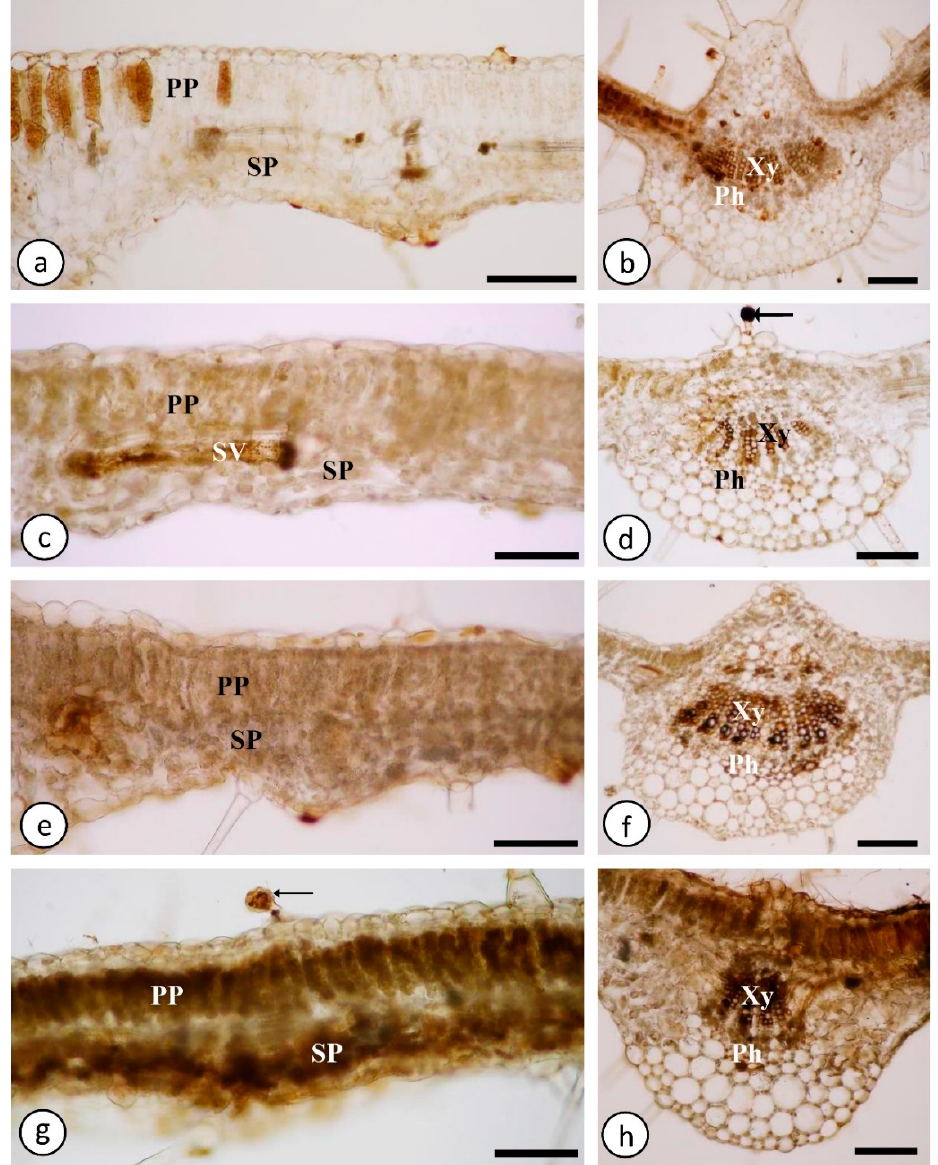
Figure 4. Photomicrographs of the median cross sections of the leaf blade of Solanum lycopersicum “cv Micro-Tom” stained with 3,3 ′ -diaminobenzidine (DAB) at 21 days after mechanical damage. ( a , b ). absence of Ca 2+ and without mechanical damage. ( c , d ). absence of Ca 2+ and with mechanical damage. ( e , f ). presence of 2 mM Ca 2+ and without mechanical damage. ( g , h ). presence of 2 mM Ca 2+ with mechanical damage. ( a , c , e , g ). Mesophyll region. ( b , d , f , h ). Midrib. PP—Palisade parenchyma; SP—Spongy parenchyma; Xy—Xylem; Ph—Phloem; SV—Smaller veins; ↑ (arrow)—Glandular trichome. Bars: (( c , e , g ) = 100 μ m); (( a , b , d , f , h ) = 150 μ m). 2.4. Performance of Chlorophyll a Fluorescence Does Not Differ between Plants Grown in the Absence of Ca 2+ with and without Damage, but There Is an Influence Resulting in Low Gas Exchange and Plant Biomass Plants grown in the absence of Ca 2+ with and without mechanical damage did not differ in chlorophyll a fluorescence performance (Figures 5 and 6). Likewise, plants grown in the presence of 2 or 4 mM Ca 2+ and with and without damage did not differ in chlorophyll a fluorescence performance (Figures 5 and 6). Plants of Solanum lycopersicum cv. Micro-Tom grown in the absence of Ca 2+ and with or without mechanical damage, in the dark, showed decreased effective quantum